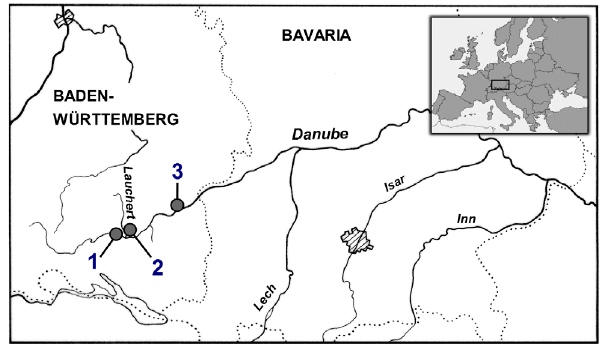
Figure 1. Sampling sites along the Danube river. 1 Sigmaringen, 2 Lauchert and 3 Ehingen. (Freely modified from